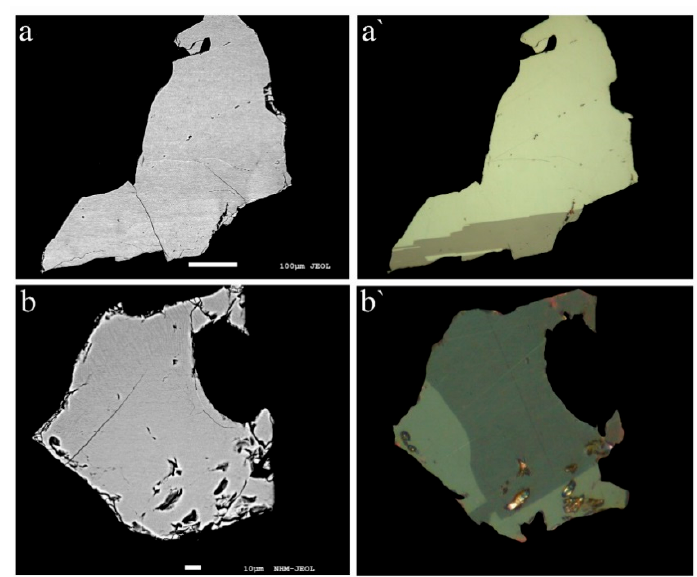
Figure 1. Representative backscattered electron images and corresponding reflected ‐ light photographs (crossed polars) of homogeneous low ‐ Tl ( a ) and high ‐ Tl ( b ) rathite grains (rath3 and rath9, respectively). Both optical images show two domains.